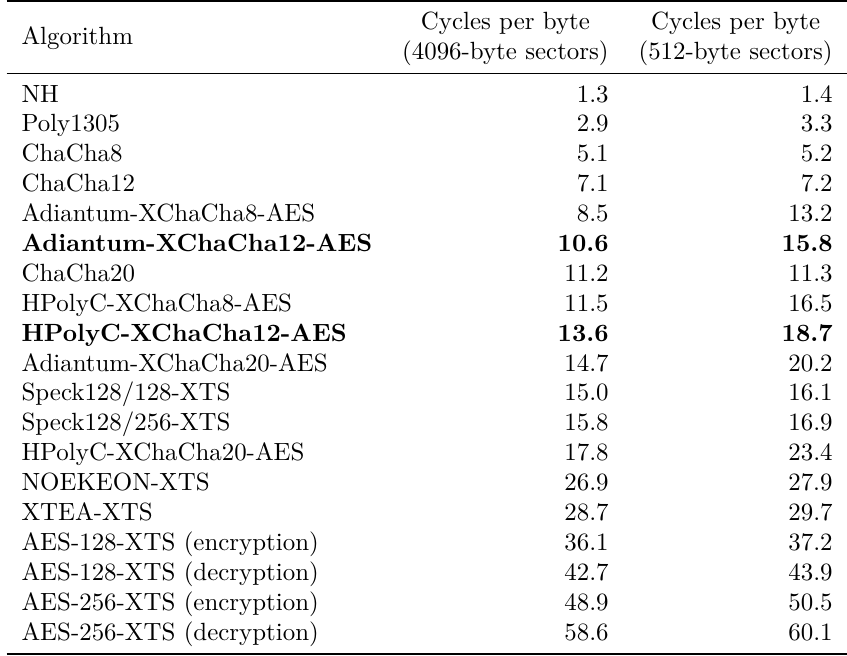
Table 1: Performance on ARM